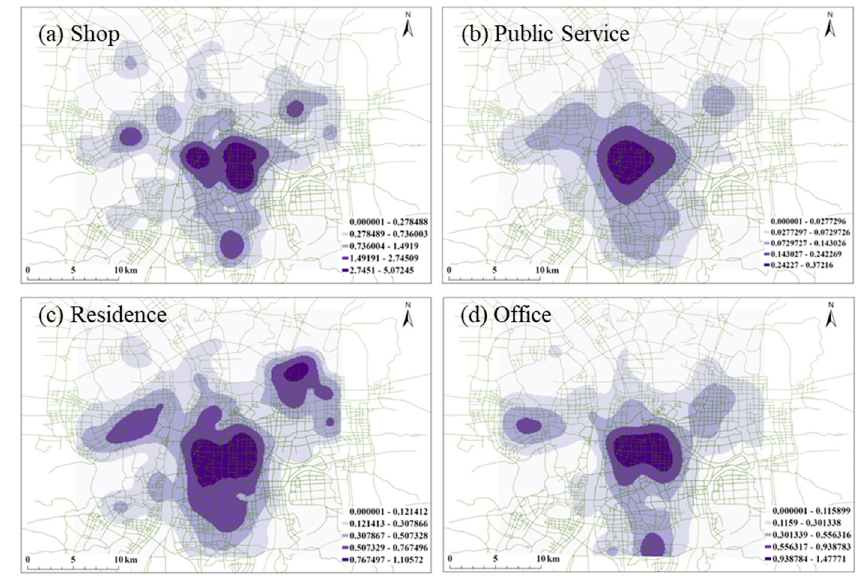
Figure 4. Kernel density distribution maps (natural breakpoint classification).